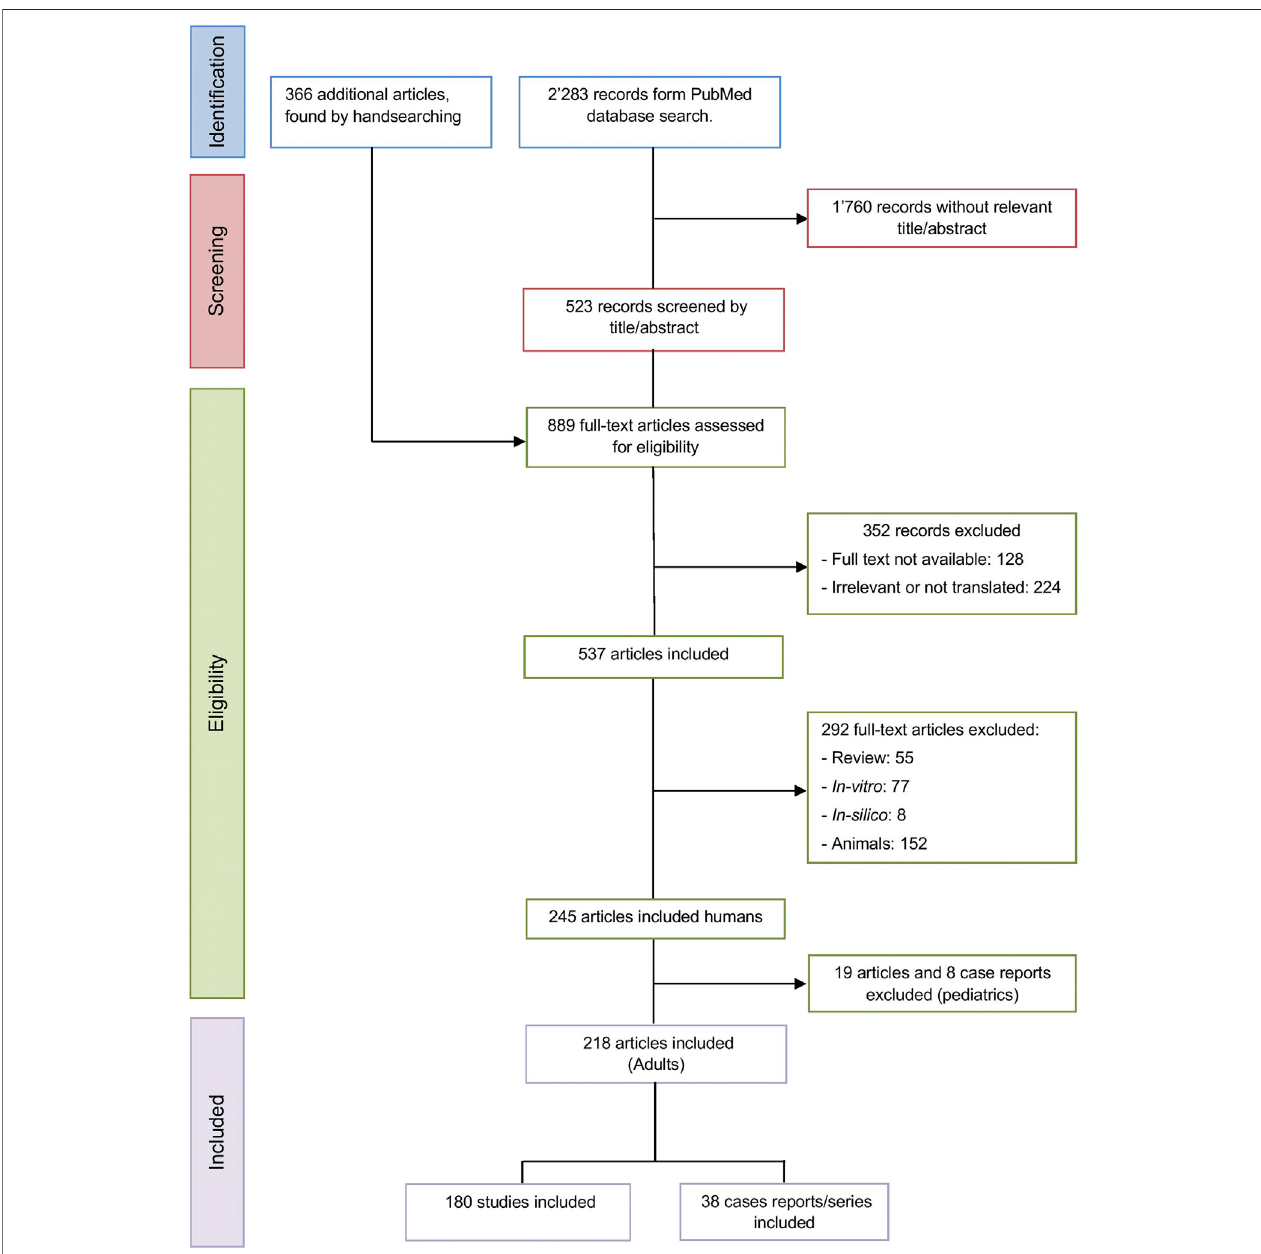
FIGURE 1 | PRISMA fl owchart of the studies selection